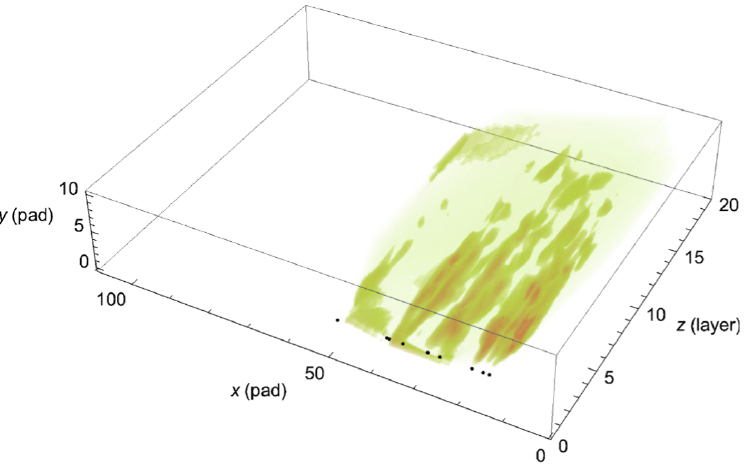
Figure 1. A simulated shower energy deposition expected within the detector upon being hit by 10 positrons (the black dots). In reality, a “pad” in the x - y plane takes an area of 5 × 5 mm 2 , and the distance between two neighbor “layers” along the z direction is 4.5